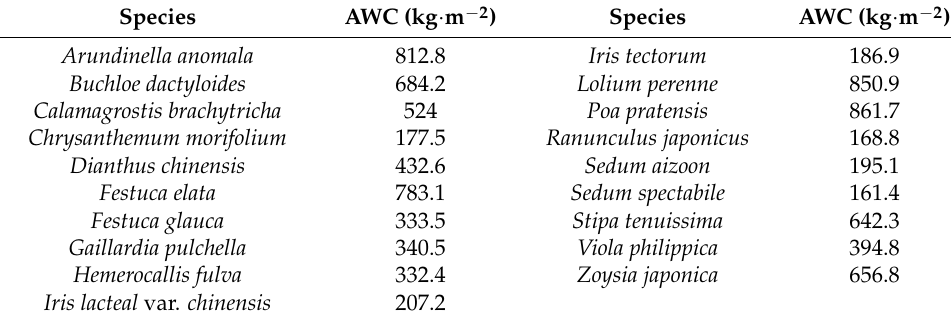
Table A3. AWC of